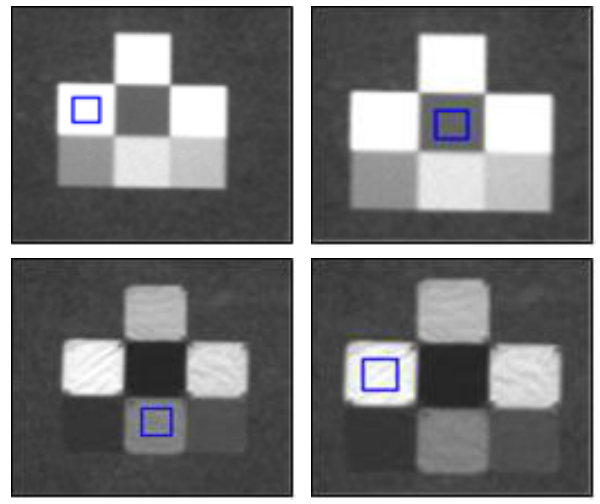
Figure 11. False alarm in the automatic target detect